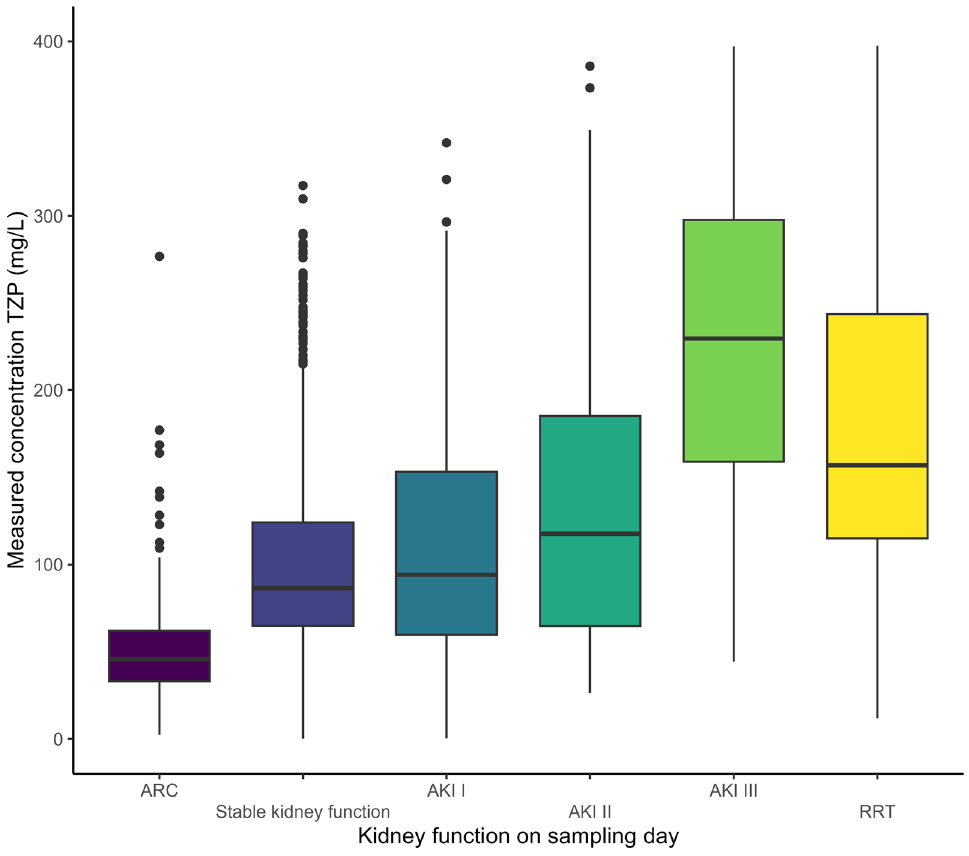
Fig. 2 Boxplot of free TZP concentrations according to renal function on the sampling